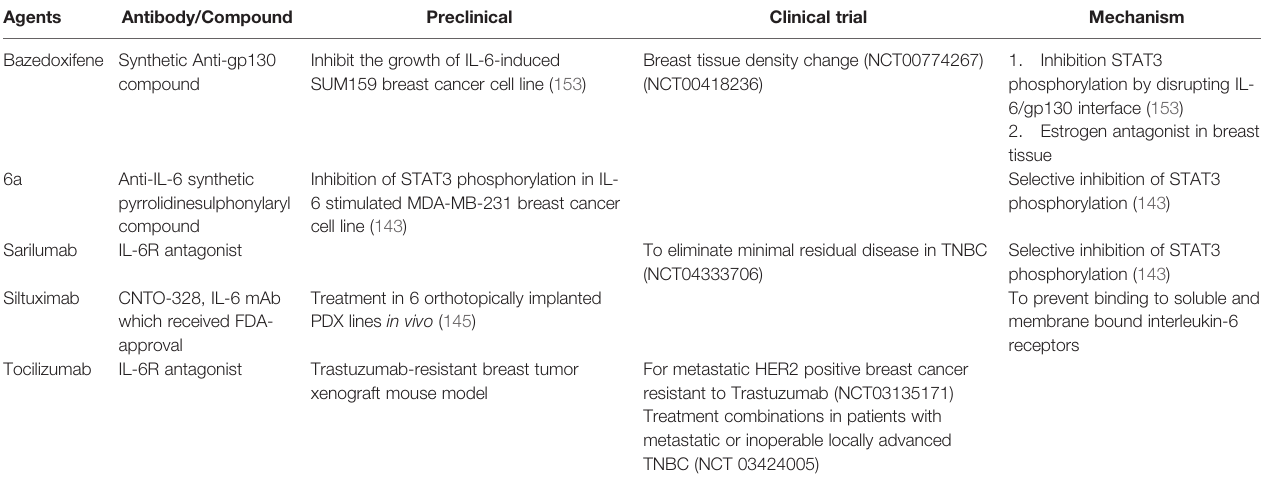
TABLE 2 | Agents directly targeting the IL-6/IL-6R/gp130 complex for breast cancer